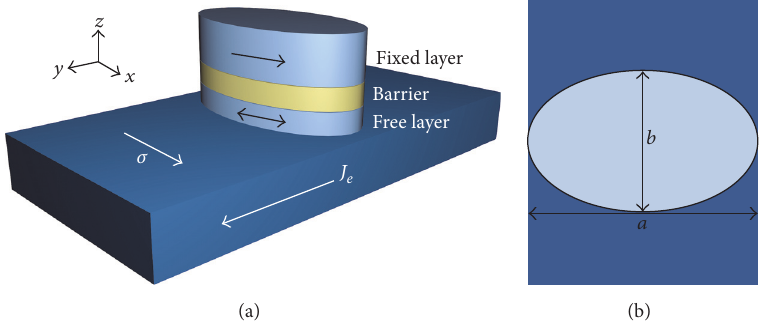
Figure 1: The sketch of in-plane SHE-RAM